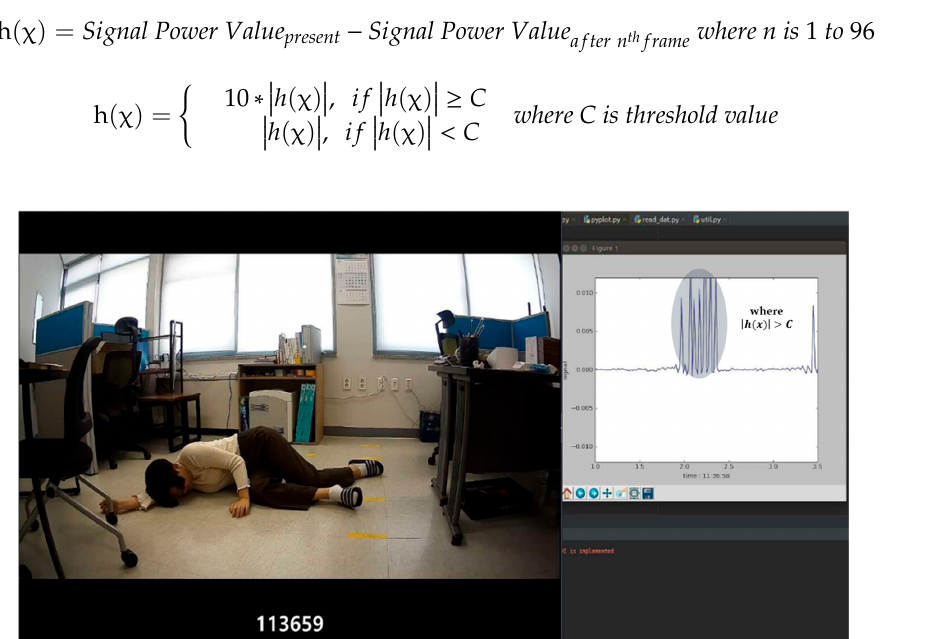
Figure 4. Visualized image of residual signal power value between current frame and the frame after 24th frame calculated according to Equations (1) and (2).